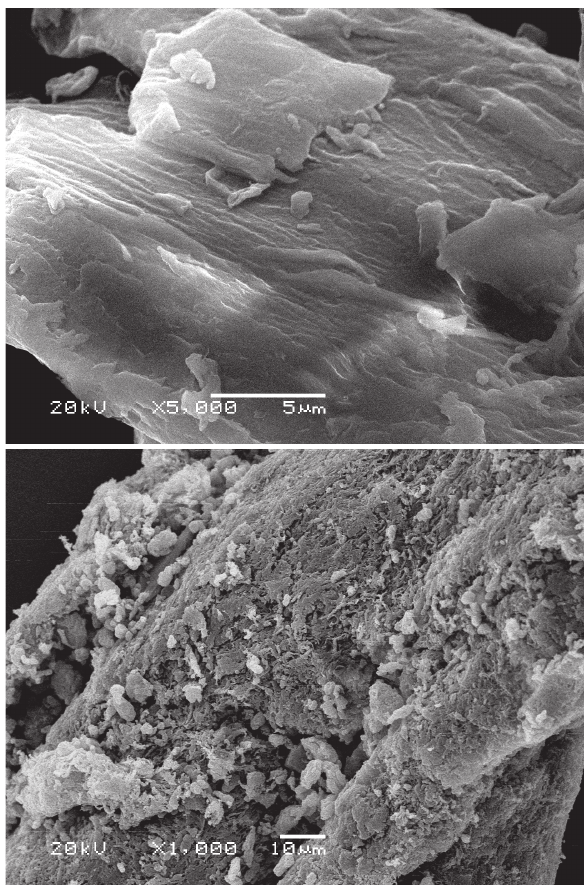
Figure 6: Scanning Electron Microscopy (SEM) of